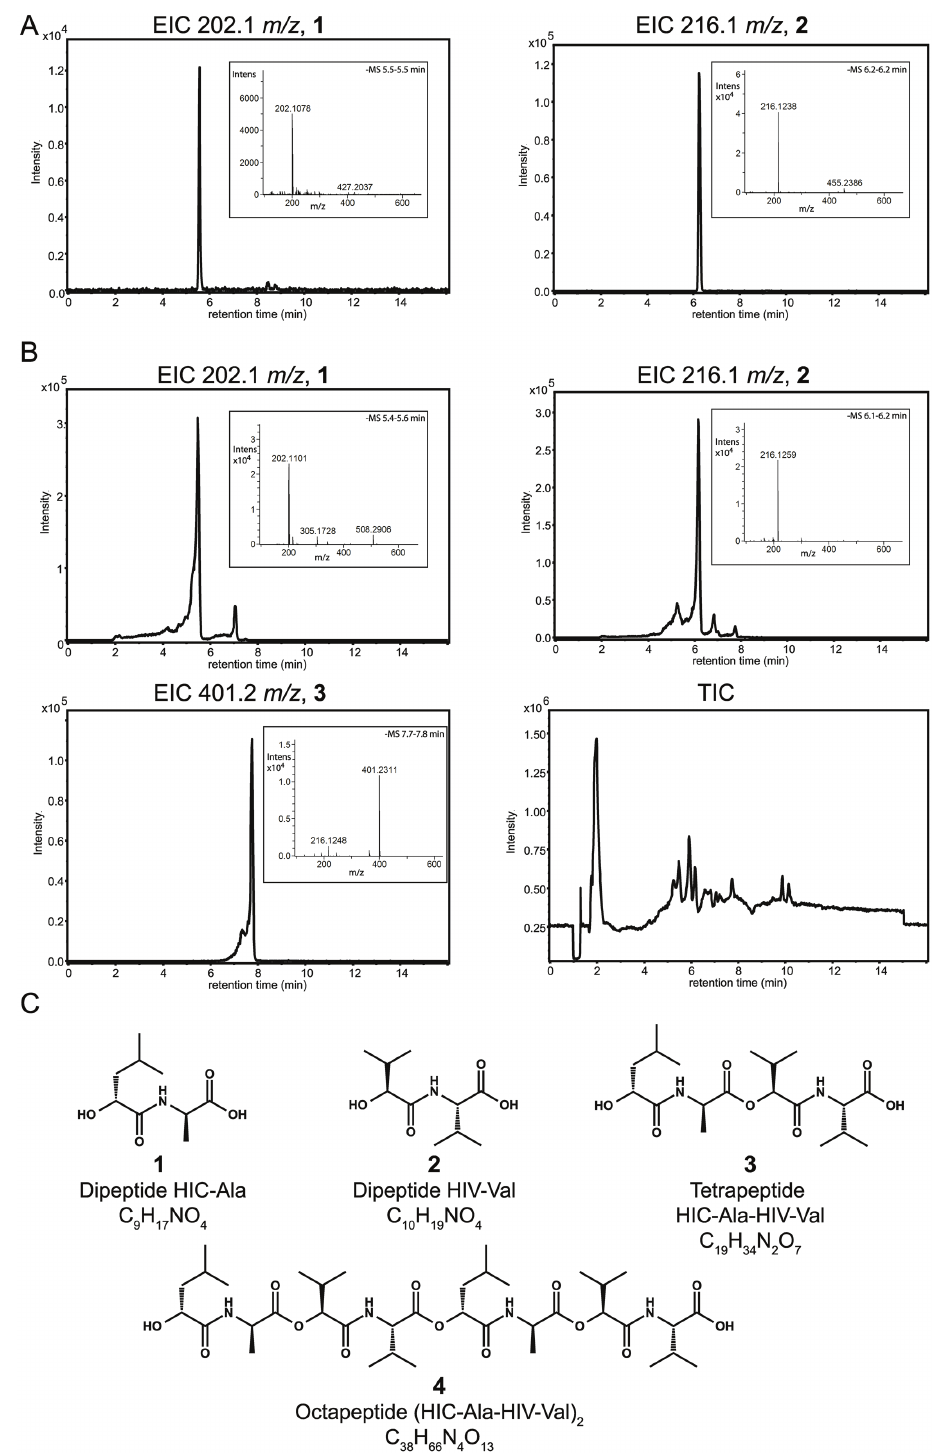
Fig 8. LC-MS analysis of the peptide synthesis reaction of in vitro- reconstituted cereulide synthetase. Extracted ion chromatograms (EIC), from (A) synthetic standards of dipeptides 1 and 2 , and (B) from the products of a peptide synthesis reaction of CesA, CesB and substrates. EICs are extracted using exact m/z values ( ± 0.05 mass units) calculated from the [M-H] - ions of the compounds shown in (C). Mass spectra corresponding to predominant peaks are shown as insets. (C) Putative chemical structures of the